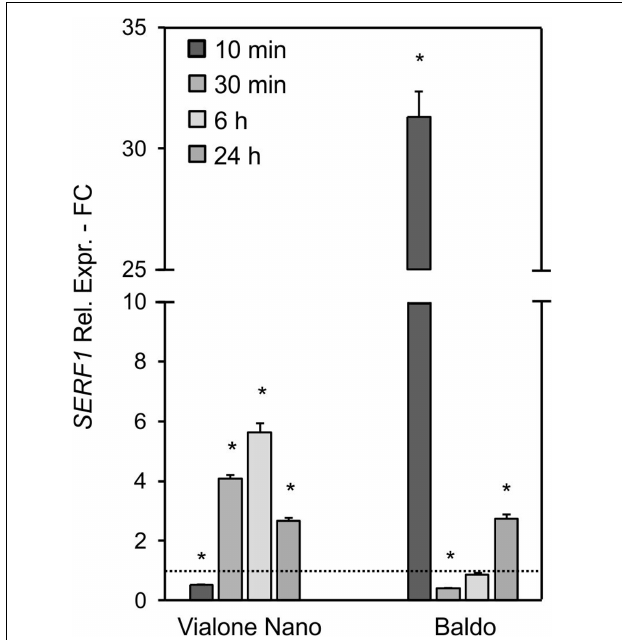
FIGURE 5 | Relative expression (fold change) of the SERF1 gene at different time points after treatment with 100 mM NaCl in VN and B. Values represent the mean ± SE of three independent experiments in duplicate. The asterisk indicates values that are significantly different from those of untreated according to Wilcoxon–Mann–Whitney’s test ( p < 0.01).